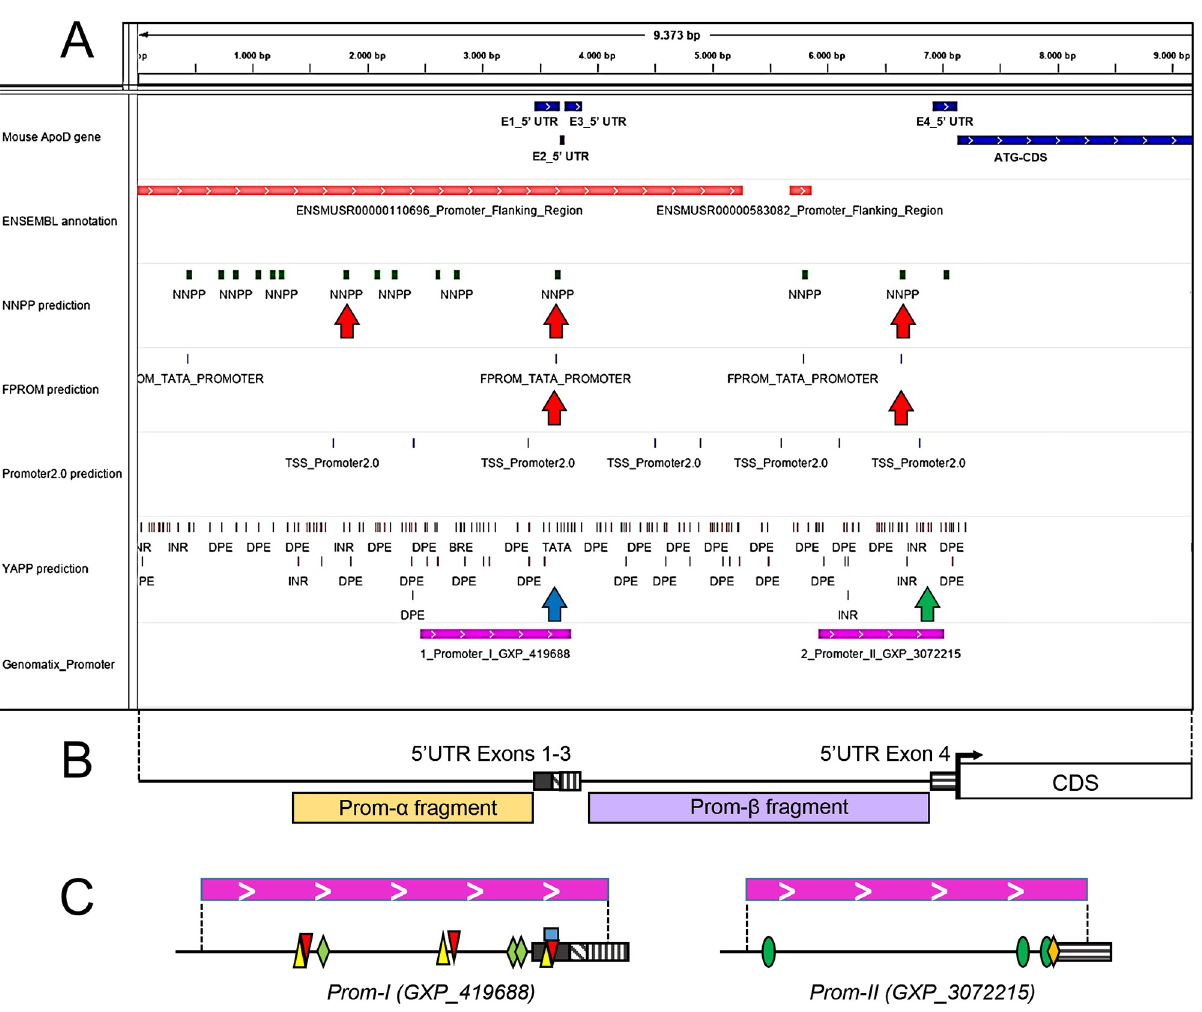
Fig 6. Promoter predictions for the mouse ApoD gene (II). A) Bioinformatic predictions of promoter elements in the upstream 5’ region of the mouse ApoD coding sequence. Information obtained from the NNPP, FPROM, YAPP and PROMOTER2_0 are visualized with the Integrated Genomics Viewer (IGV). Three high score NNPP-predicted and two FPROM-predicted initiation sites are noted by red arrows. Blue arrow points to the TATA box-containing initiation site in Promoter I (canonical α ), as predicted by YAPP. Green arrow points to predicted initiator (INR) and downstream promoter element (DPE) in Promoter II (alternative β ) optimally spaced (20–30 bp) for transcription initiation upstream of the 5’ UTR exon 4. Purple bars delimit the promoter regions identified by Genomatix. B) Schematic representation of the mouse ApoD locus drawn at the same scale as panel A. Promoter fragments α (2 Kb) and β (3 Kb) cloned for Luciferase assays are represented. They include the regions identified by Genomatix (GXP) as Promoter I and Promoter II respectively. C) Transcription factor binding sites predicted by ModelInspector are mapped onto the GXP promoter regions (enlarged scale). NFKB (yellow triangles), NFAT (red triangles), CBF α (green diamonds), AP1 (blue rectangle), CEBP (green ovals), SP1 (orange diamond). Binding of multiple factors is predicted at various locations.